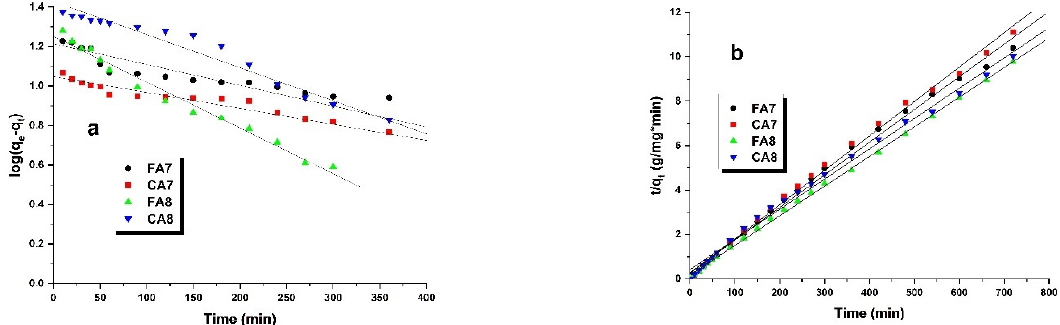
Figure 7. Pseudo-first-order ( a ) and pseudo-second-order ( b ) kinetic plots for adsorption of methyl red sodium salt onto